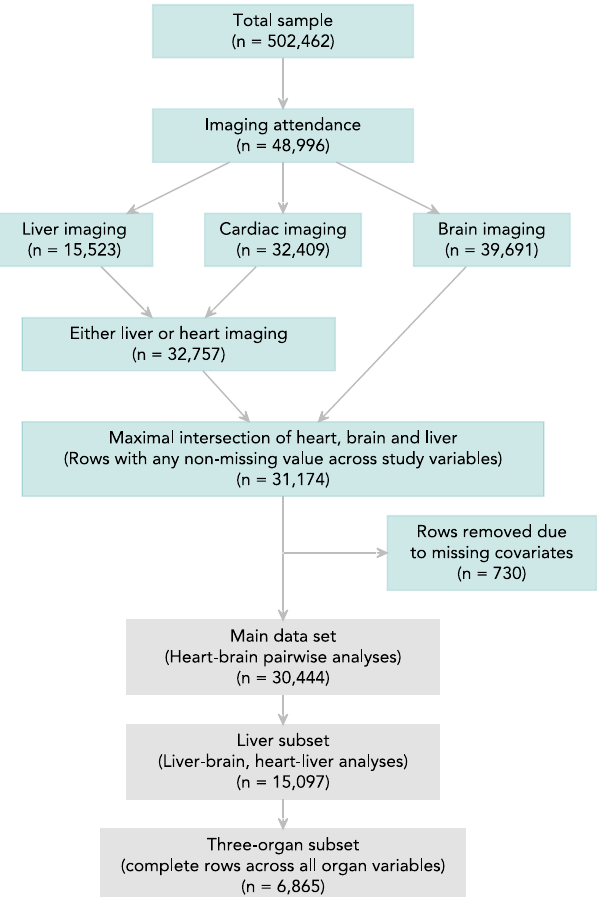
Fig. 2 | Study sample. Across the UK Biobank cohort, 48,996 participants had a record of an imaging attendance of any type. Relevant brain imaging data was available for 39,691 participants, cardiac imaging was available for 32,409 partici- pants, and liver imaging was available for 15,523 participants. The maximum pos- sible set at the intersection of brain imaging plus either liver or heart imaging contained 31,174 participants. We excluded 730 (2%) participants with missing covariate data, leaving a main set of 30,444 participants. This set was used for the pairwise heart-brain analyses. Within the main set, a subset of 15,097 participants had at least one piece of liver imaging data. This is the liver subset and this forms the basis of the pairwise liver-brain and liver-heart analyses. Even so, there is still